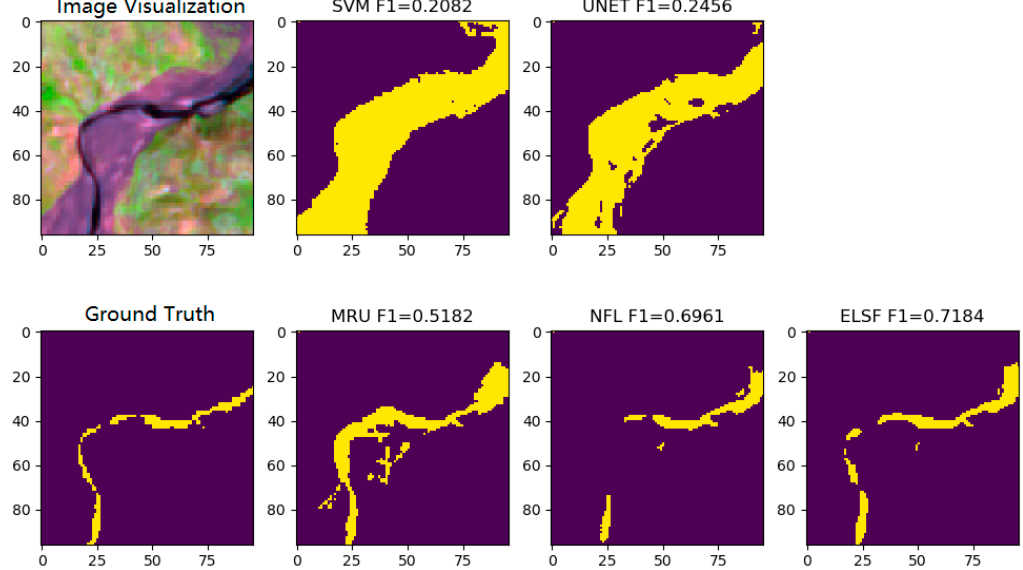
Figure 15. Figures of sample visualization, SVM, UNet segmentation binary results (row 1), sample ground truth, MultiResUNet, NFL, ELSF segmentation fraction results (row 2).